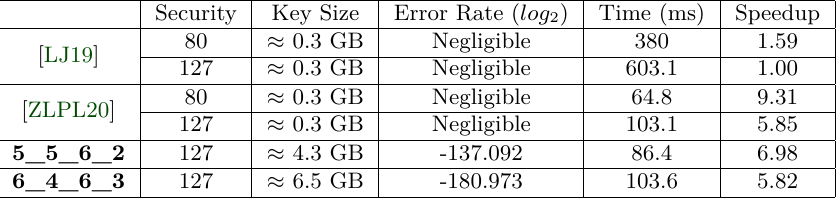
Table 6: Comparison between implementations of an 8-bit ReLU